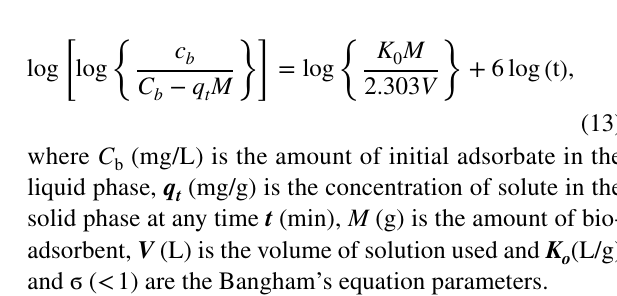
Fig. 4 Kinetic model for Ni(II) adsorption. a Pseudo-first-order, b pseudo-second order, c Bangham, d intraparticle diffusion, e Elovich models [initial Ni(II) conc. = 100 mg/L; contact time = 15–300